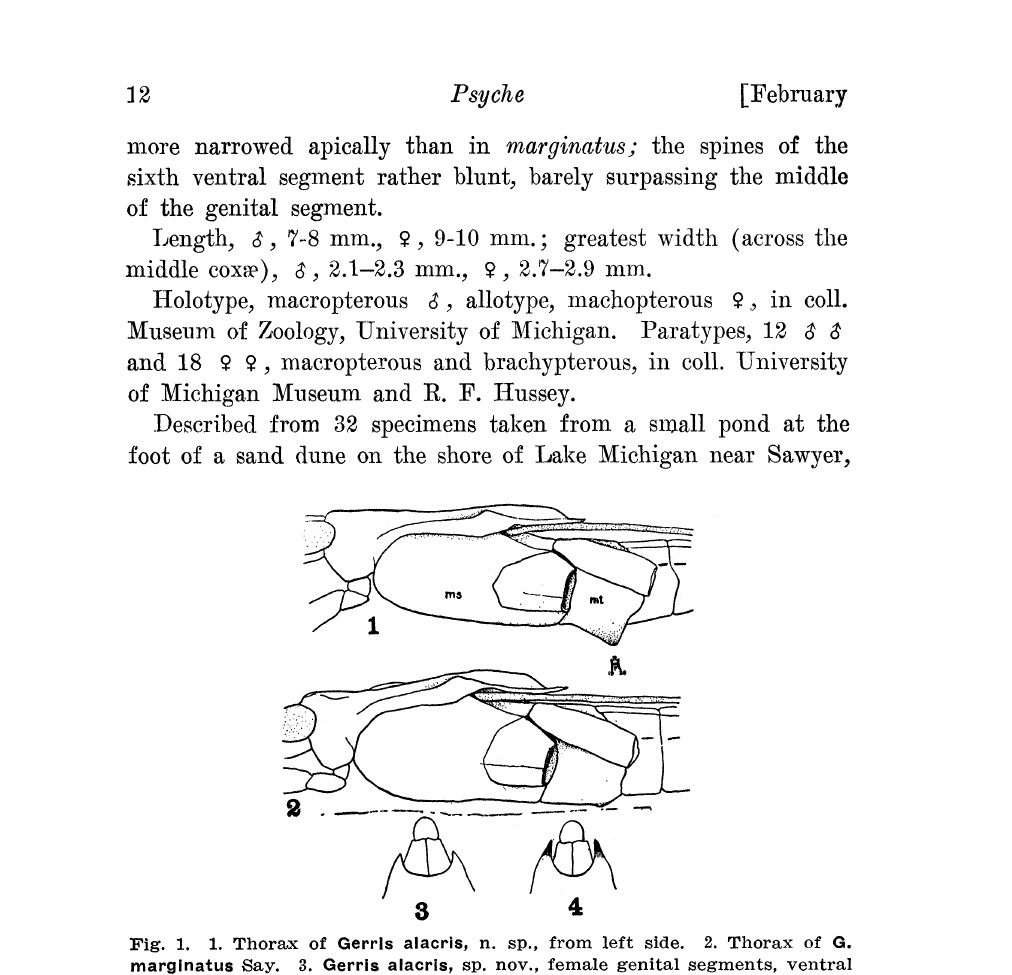
Fig. 1. 1. Thorac( of (err|s alacris, n. sp., from left side. 2. Thorax of marlinatus Say. 3. (eri. aacri, sp. nov., female genital segments, ventral aspect. 4. (. rnainatu Say, female genit,ul